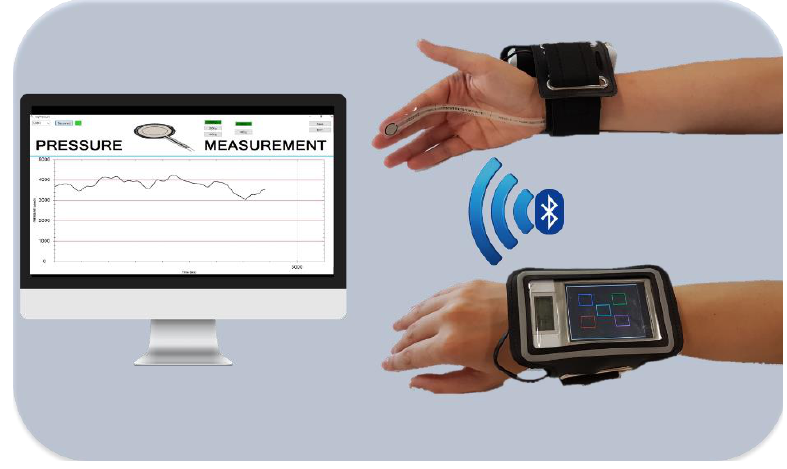
Figure 1. Instrument to monitor and register the pressure.